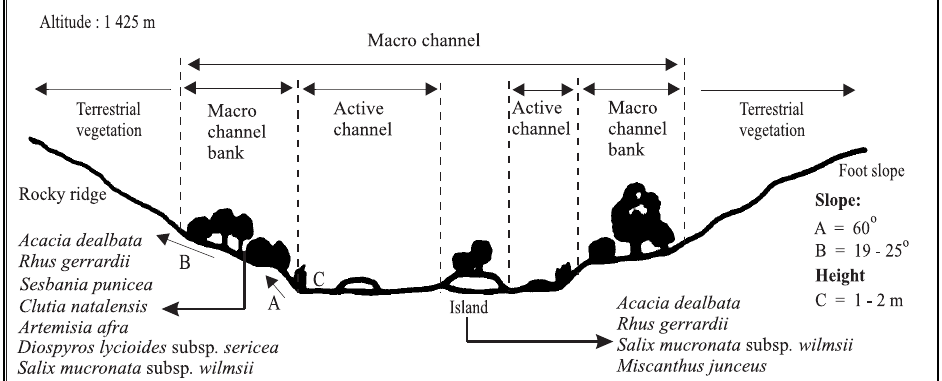
Fig. 9. River profile of the Acacia dealbata-Eragrostis curvula